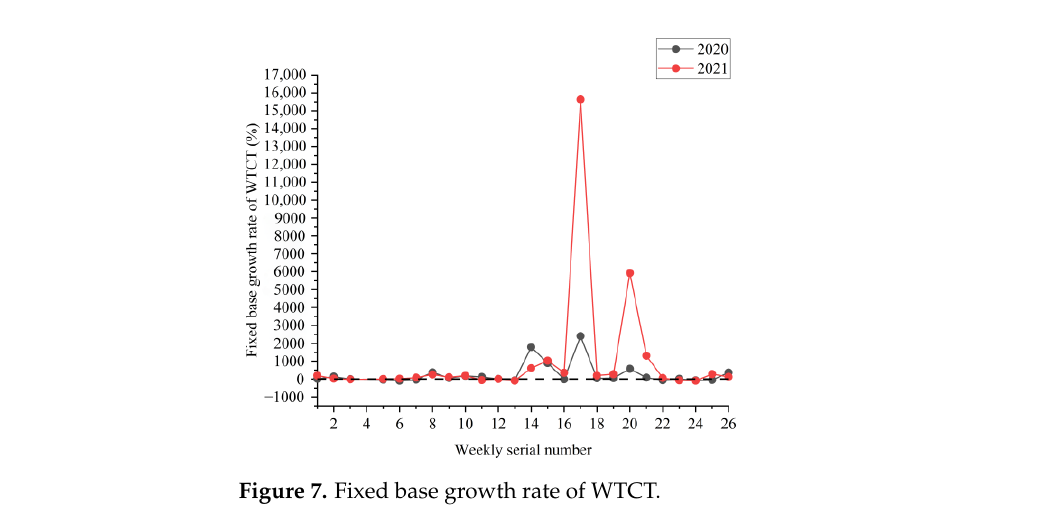
Figure 6. Fixed base growth rate of WTIT.